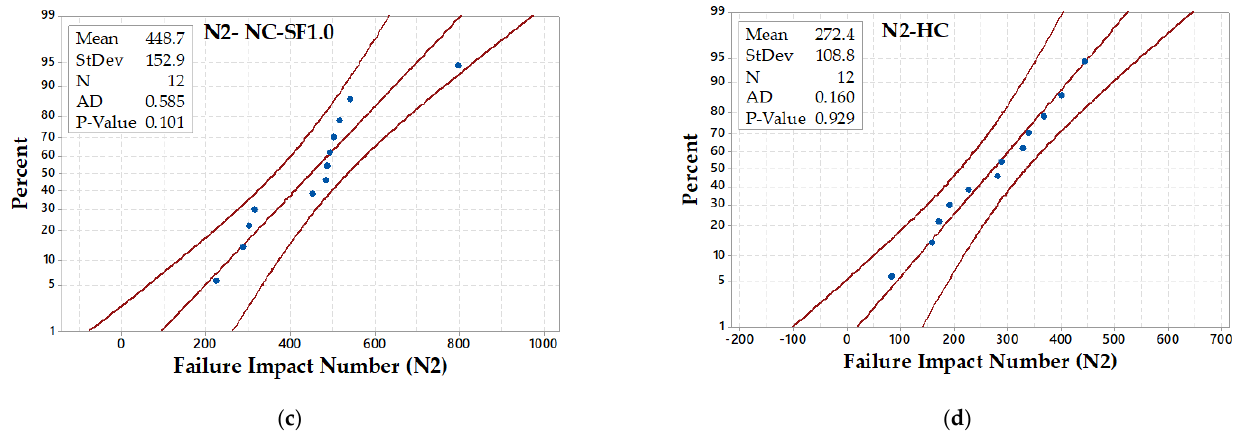
( d ) Figure 10. Normal probability plots of the results at the cracking stage for mixtures ( a ) NC ( b ) NC-SF0.5 ( c ) NC-SF1.0 and ( d ) HC.